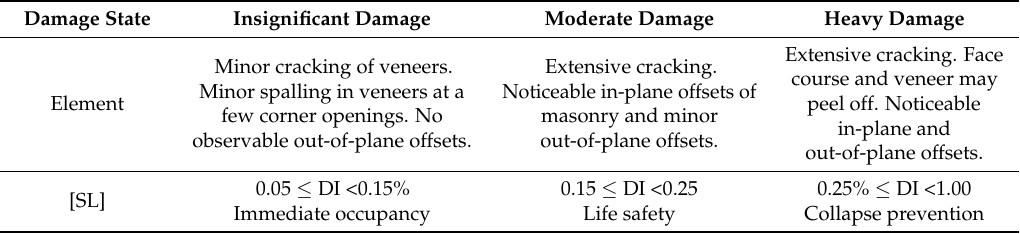
Figure 14. Definition of Limit States (LS) thresholds and Damage States (DS) ranges. Table 4. Proposed Structural Performance Levels for un-reinforced masonry.